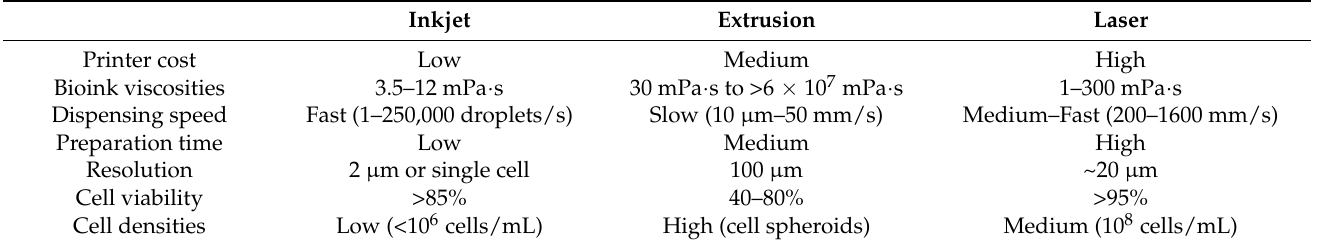
Table 1. Comparison of 3D cell-printing